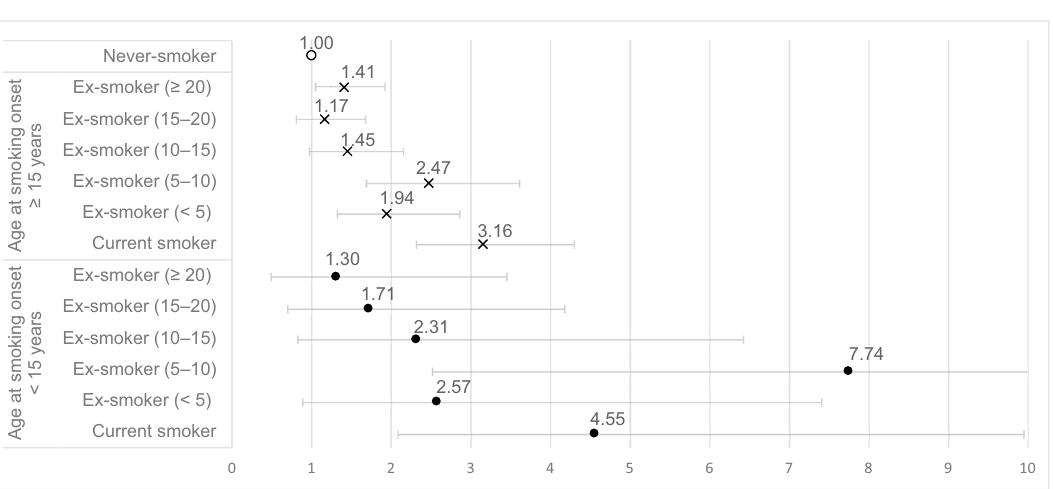
Figure 2. Association between smoking cessation status and obstructive spirometry pattern according to the age at smoking onset in men. Adjusted for cumulative smoking exposure, age, educational level, household income, occupation, residential area, physical activity, high-risk drinking, and